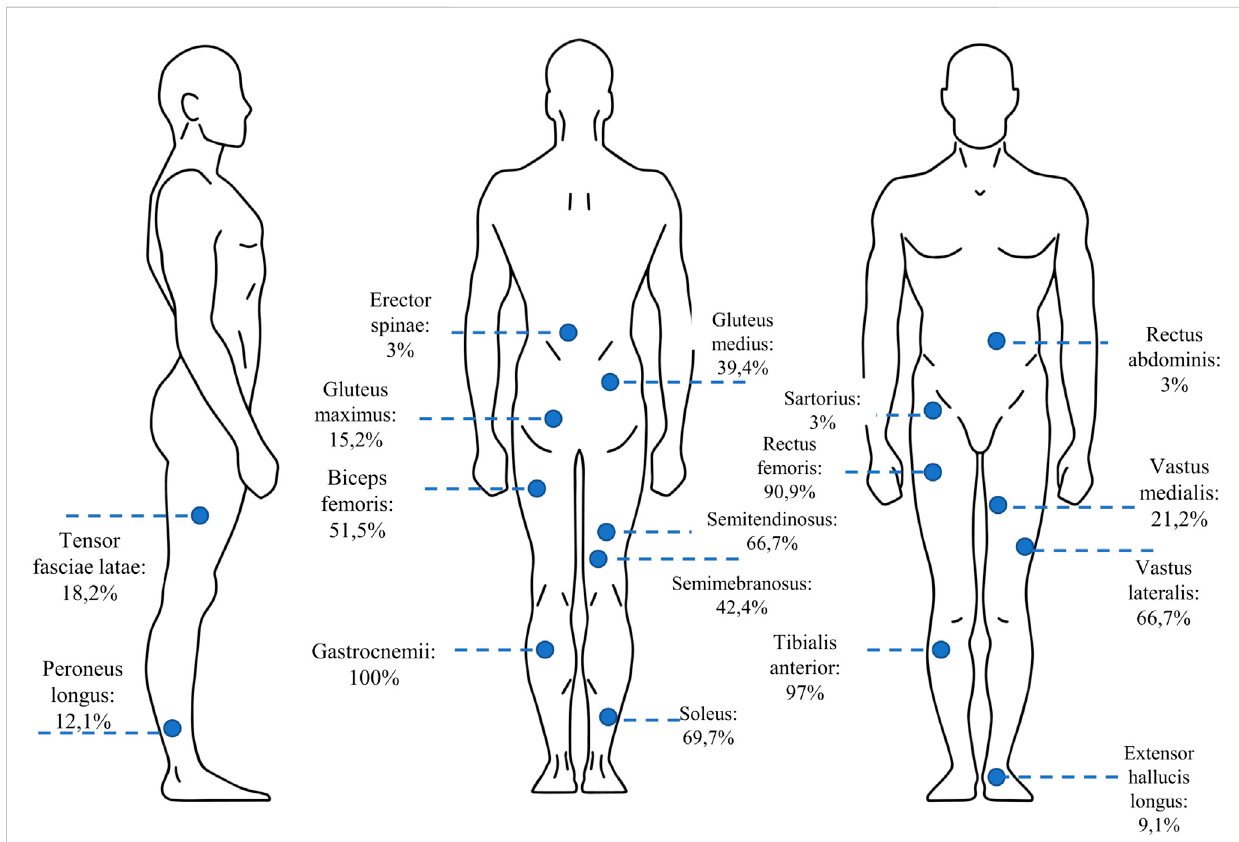
FIGURE 3 The percentage of the studies in which each of the lower-limb muscles was selected for muscle synergy analysis.